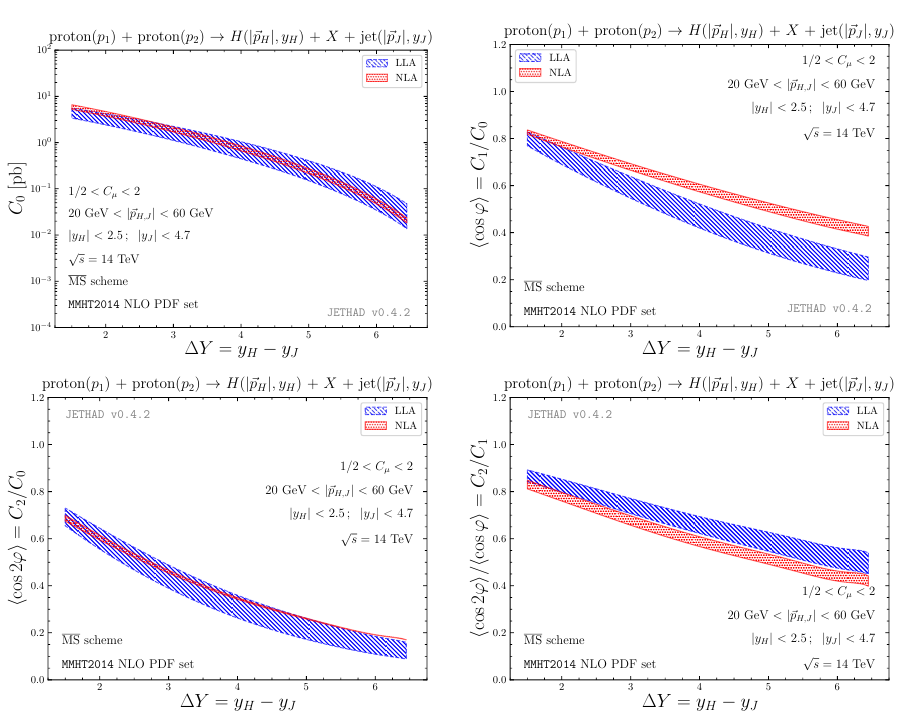
/ C m ≡ C , for the inclusive n n m